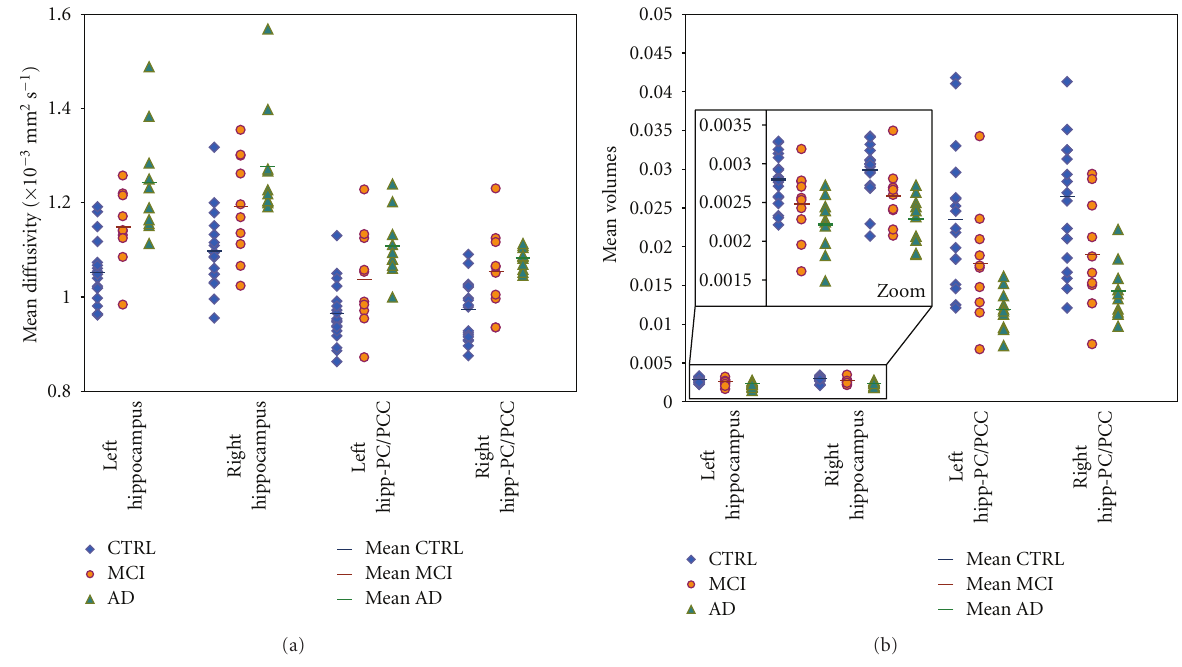
Figure 2: Individual data plotting of MD and relative volumes in hippocampi and correlated structures, in order to estimate the ability of the techniques to discriminate AD, MCI, and healthy controls. (a) Plot of MD values for each subject in left and right hippocampus and in left and right tracts connecting hippocampus to PC/PCC for healthy controls (blue), MCI (orange), and AD (green) subjects. Average MD value is represented by a di ff erent color line for each group. (b) Plot of relative volumes values for each subject in left and right hippocampus and in left and right tracts connecting hippocampus to PC/PCC for healthy controls (blue), MCI (orange), and AD (green) subjects. Average relative volume value is represented by a di ff erent color line for each group.